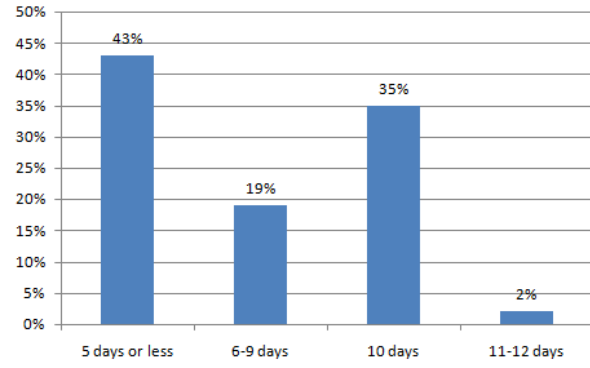
Figure 1. Duration of zinc therapy in days (n = 82